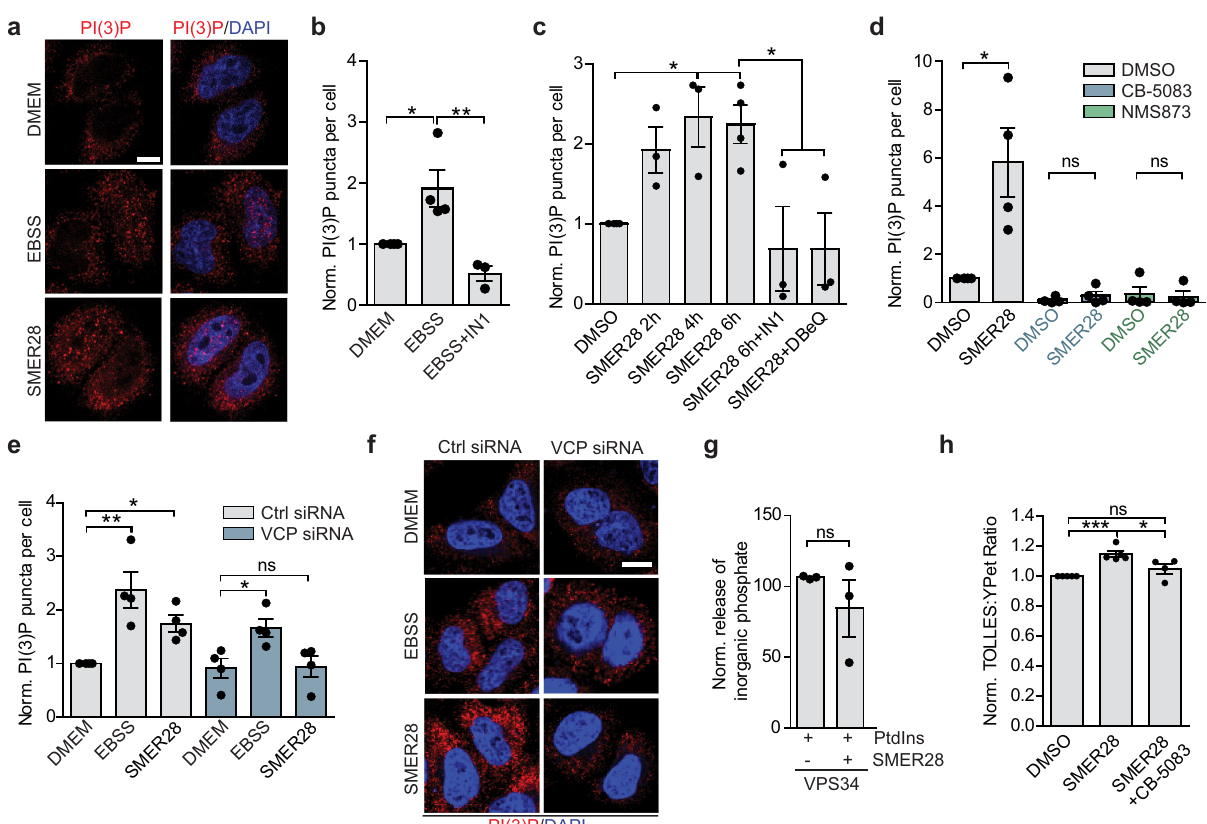
Fig. 3 Autophagy induction by SMER28 depends on VCP and PI3K activity. a – c PI(3)P puncta in HeLa cells in basal (DMEM), starvation (EBSS 1 h; a , b ) and in basal conditions treated with 20 μ M SMER28 ( a , c ) or with or without 1 μ M VPS34 inhibitor (IN1) or 10 μ M DBeQ for indicated time points ( b , c ); PI(3)P puncta per cell normalized to control; n = 4 representative images in a ; quanti fi cation in b (one-way ANOVA: P = 0.004 with post hoc Tukey test; EBSS P = 0.0255, EBSS + IN1 P = 0.0039) and in c (for SMER28 treatment alone: one-way ANOVA: P = 0.0079 with post hoc Tukey test, 4 h SMER28 P = 0.0131, 6 h SMER28 P = 0.0126; for SMER28 6 h treatment with or without inhibitors: one-way ANOVA: P = 0.0153 with post hoc Tukey test, SMER28 + IN1 P = 0.0284, SMER28 + DBeQ P = 0.028). d PI(3)P puncta in cells treated with 20 μ M SMER28 for 6 h with or without 5 μ M CB-5083, 10 μ M NMS873; n = 4; two-tailed paired Student ’ s t test; DMSO vs. SMER28 P = 0.0444. e , f PI(3)P puncta in control and VCP knockdown HeLa cells in basal (DMEM), starvation (EBSS 2 h) and in basal conditions treated with 20 μ M SMER28 for 4 h; n = 4; representative images in f ; quanti fi cation in e (for control siRNA cells: one-way ANOVA P = 0.0022 with post hoc Tukey test; for VCP knockdown cells: one-way ANOVA P = 0.0294 with post hoc Tukey test). g Puri fi ed VPS34 was incubated in the presence of phosphatidylinositols (PtdIns) and ATP with 20 μ M SMER28 for 20 min. The levels of inorganic phosphate were measured; n = 3; paired two-tailed Student ’ s t test. h SRAI-LC3B cells were treated with 20 μ M SMER28 in the presence or absence of 0.3 μ M CB-5083 for 24 h, followed by FACS analysis, n = 5; one-way ANOVA: P = 0.01 with post hoc Tukey test (DMSO vs. SMER28 P = 0.0008, CB- 5083 P = 0.0213). Data presented as normalized mean ± SEM, * P < 0.05, ** P < 0.001, *** P < 0.0001; scale bar = 10 μ m; ns not signi fi cant. Source data are provided as a Source Data fi